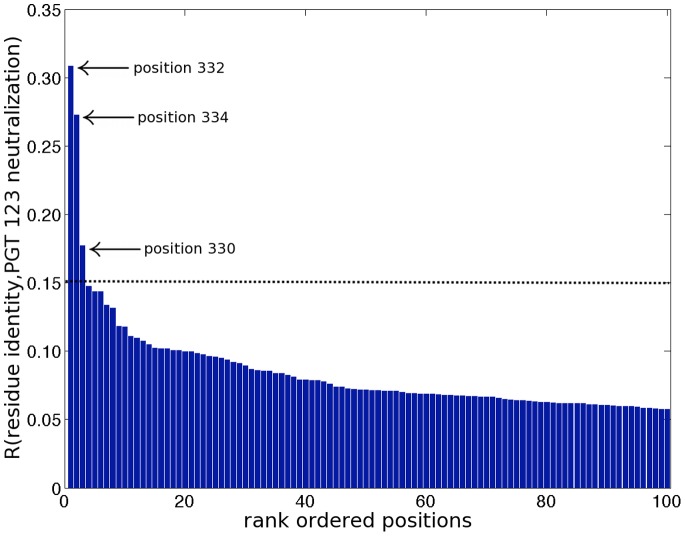
Mutual information (MI) selection of PGT-123 epitope positions.The redundancy spectrum produced by application of the mutual information classification algorithm to the neutralization activity of bnMAb PGT-123 against a panel of 141 HIV-1 pseudoviruses (cf. Table S1) using an IC50 cutoff of 10 µg/ml. The ordinate records the computed redundancy of the residue identity in each position with the observed neutralization activity. The abscissa lists the positions of the protein in decreasing order of redundancy. The dashed line indicates the cutoff computed by the shuffling procedure described in Materials and Methods, Rcutoff = 0.15, above which redundancy values should be considered statistically significant. These results suggest that the three top ranked positions – respectively, 332, 334 and 330– be retained in the model (cf. Table 1). For clarity of viewing, plots are terminated at the 100-component model.